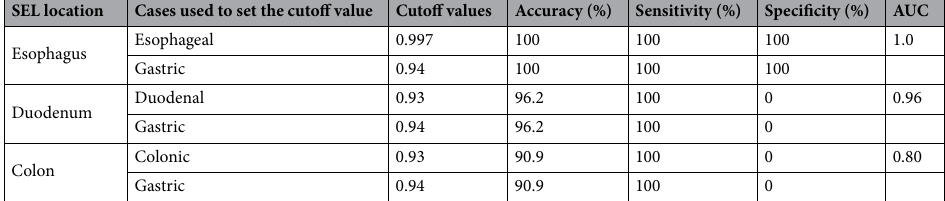
Table 3. Diagnostic ability of EUS-AI according to cutoff values. AUC, area under the curve; EUS-AI, endoscopic ultrasound-based artificial intelligence; SEL, subepithelial lesion.